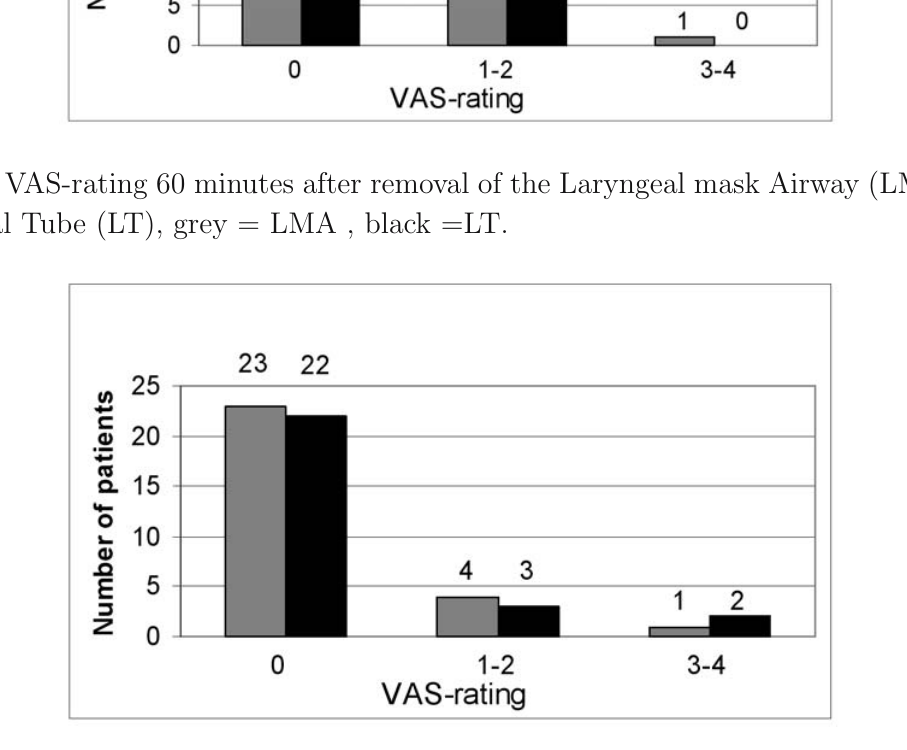
Fig. 2.c VAS rating 24 hours after removal of the Laryngeal mask Airway (LMA) and Laryngeal Tube (LT), grey = LMA , black